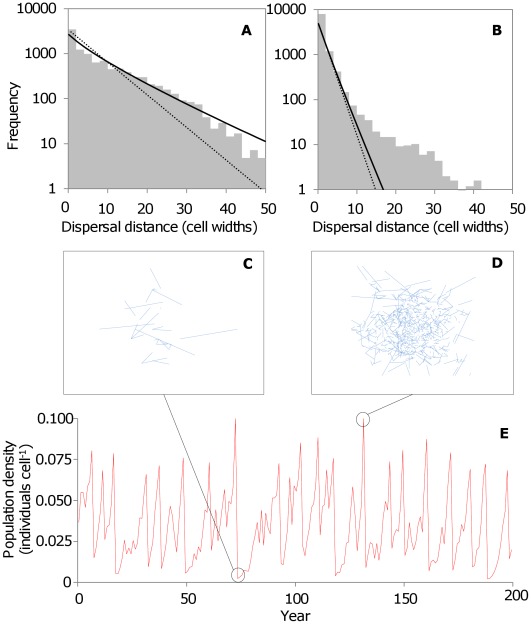
Simulations of dispersal in a simple non-territorial organism with promiscuous mating.These figures show example outputs from the promiscuity model, where individuals of both sexes settle as soon as they locate a cell containing at least one member of the opposite sex. Histograms show frequency distributions of annual dispersal distances from years with the lowest (A) and highest (B) densities, using binned data from a 300 year simulation run (excluding 100 year burn-in period; A = lowest density bin, <0.005 individuals cell−1; B = highest density bin, >0.095 individuals cell−1). Lines show negative exponential (hatched line) and Weibull (solid line) functions fitted to the data, indicating a fat-tailed distribution (Weibull k<1) at low densities. Insets show examples of linear dispersal movements for individual years at low (C) and high (D) density. Population density fluctuates annually due to density dependent survival, as shown in an example 200 year run following a 100 year burn-in (E).